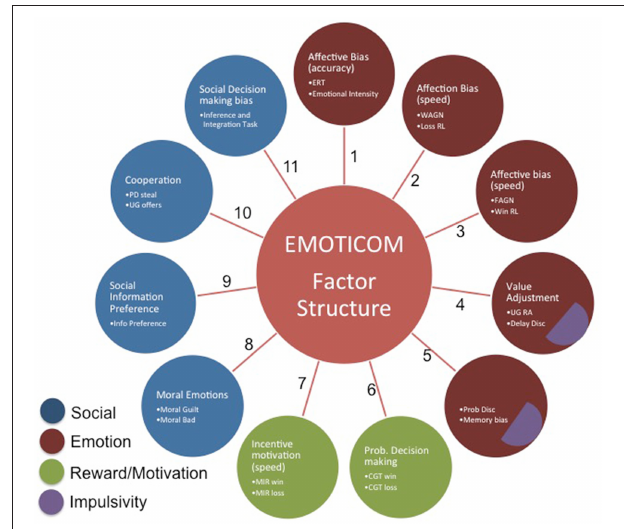
FIGURE 1 | Eleven-factor solution derived from an exploratory factor